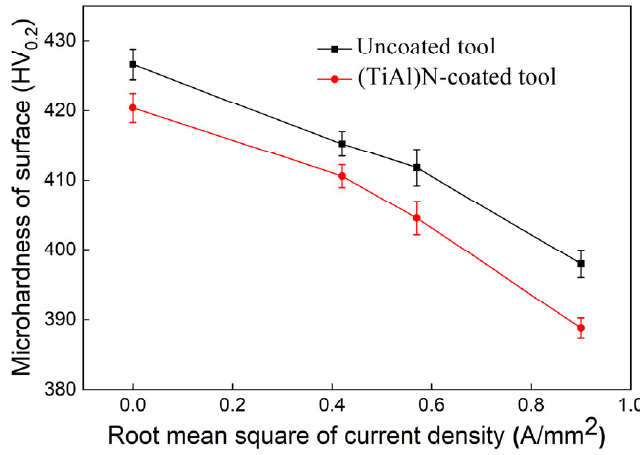
Figure 8. Change in the microhardness of the machined surface with the increase in current density.